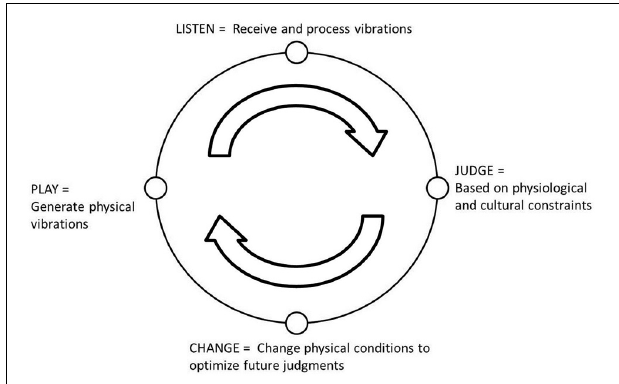
FIGURE 1 | Adapted from Marc Leman’s (2008) Action-Reaction Cycle for embodied music